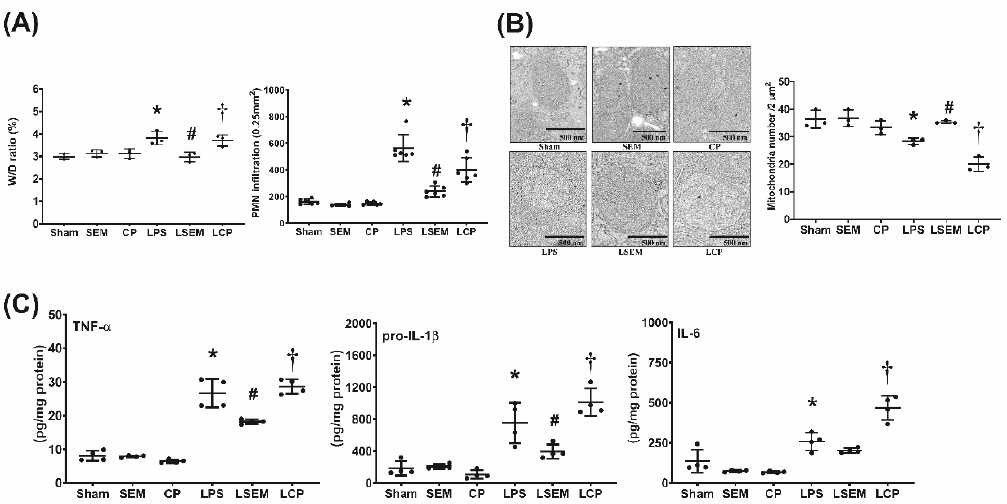
Figure 4. SEM18 peptide mitigates endotoxin-induced inflammation and mitochondrial injury in liver tissues induced by endotoxin. ( A ) Wet/dry (W/D) weight ratio and polymorphonuclear leukocyte (PMN) infiltration levels in liver tissues, as measured at 24 h after lipopolysaccharide (LPS) or normal saline (NS) administration. ( B ) Hepatic concentrations of tumor necrosis factor-α (TNF-α), pro-interleukin-1β (pro-IL-1β), and IL-6, as measured at 24 h after LPS or NS administration using enzyme-linked immunosorbent assay (ELISA). ( C ) Representative transmission electron microscopic images of mitochondria in liver tissues (12,000×) and the mean intact mitochondrion numbers (per 2 μm 2 ) in liver tissues, as measured at 24 h after LPS or NS administration. Sham: the NS group; SEM: the NS plus SEM18 peptide group; CP: the NS plus control peptide (CP) group; LPS: the LPS (15 mg/kg) group; LSEM: the LPS (15 mg/kg) plus SEM18 peptide group; LCP: the LPS (15 mg/kg) plus C group. Data are the mean ± standard deviation. Data of W/D weight ratio, PMN infiltration, ELISA, and mitochondrial injury assay were derived from three, six, four, and three mice from each group, respectively. * p < 0.05, the LPS group vs. the sham group; # p < 0.05, the LSEM group vs. the LPS group; † p < 0.05, the LCP group vs. the LSEM group .